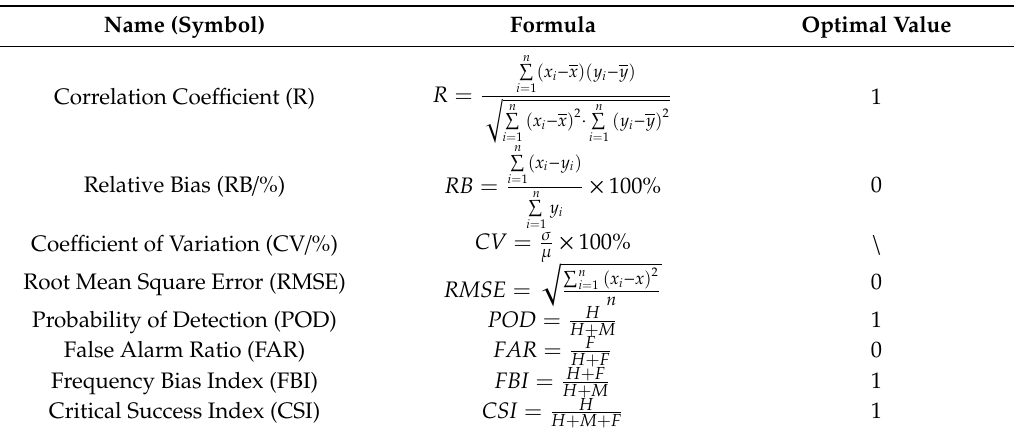
Table 2. List of the statistical